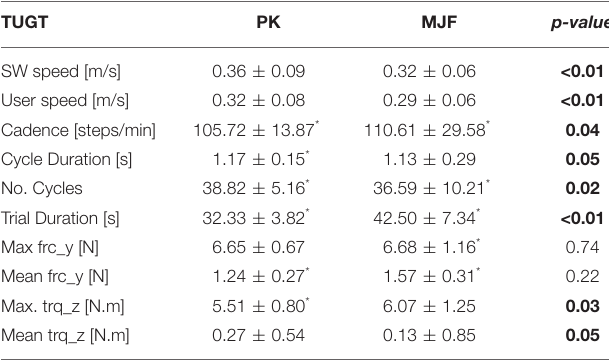
TABLE 6 | Results obtained for the Timed Up and Go Test (TUGT).